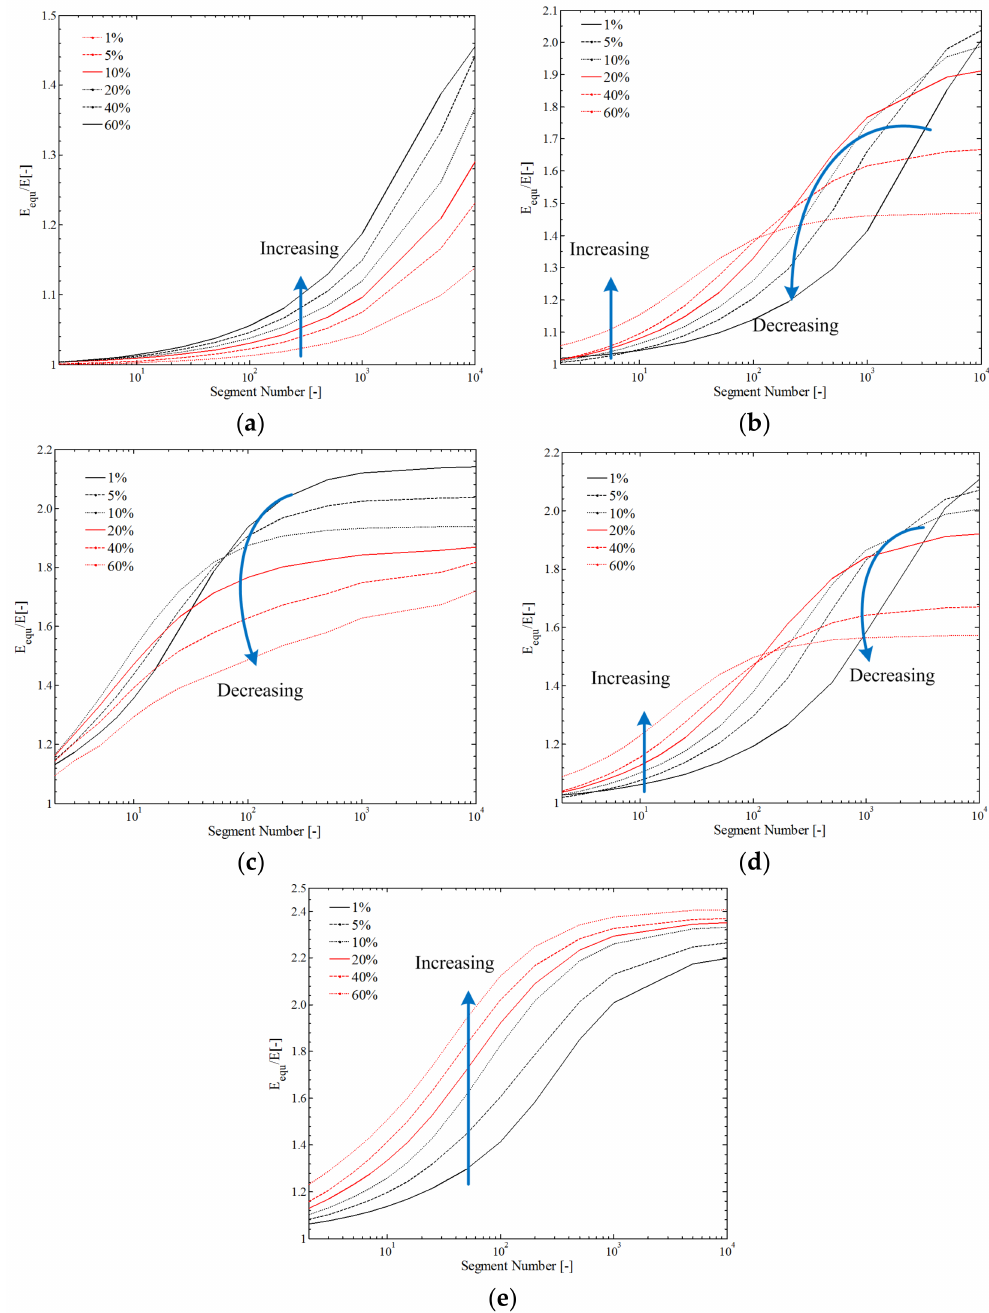
Figure 14. The effect of internal geometry on the equivalent elastic modulus: ( a ) r p / l = 100; k = 1; ( b ) r p / l = 10; k = 1; ( c ) r p / l = 1; k = 1; ( d ) r p / l = 10; k = 2; ( e ) r p / l = 10; k =